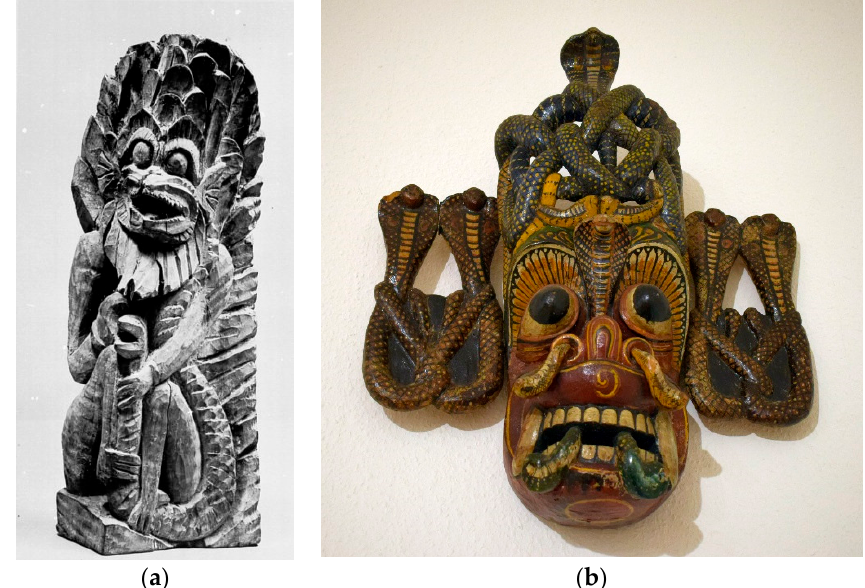
Figure 5. ( a ) Balinese wooden sculpture of a serpent being devoured by Garu ḍ a (purchased 1959 by Friedrich Heiler for the Marburg Museum of Religion, acc.nr. Ar 079); ( b ) Nâga-râssa from Sri Lanka, used for mask dance performances, in which the N ā gas fight against their enemies, the Grurlâ, i.e., Garu ḍ a (purchased for the Marburg Museum of Religion in 1967 from Julius Konietzko, photo by Heike Luu, acc.nr. Lp 227).